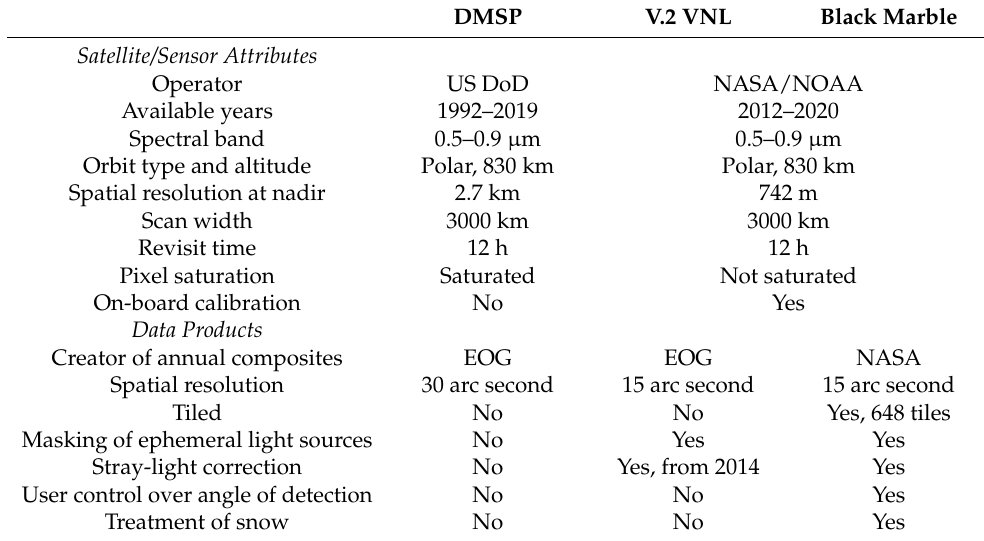
Table 1. Attributes of the various NTL data sources and data products.